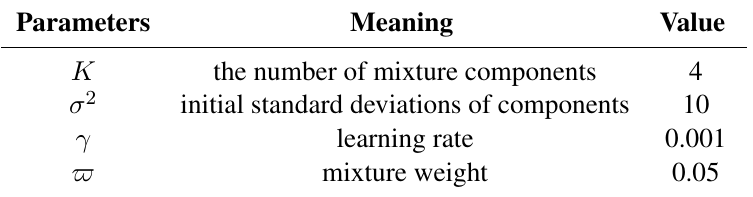
Figure 5. Background absorption of tamper attacks: ( a ) current image; ( b ) background image. Table 1. Parameters of Gaussian mixture model (GMM) in the proposed tamper detection